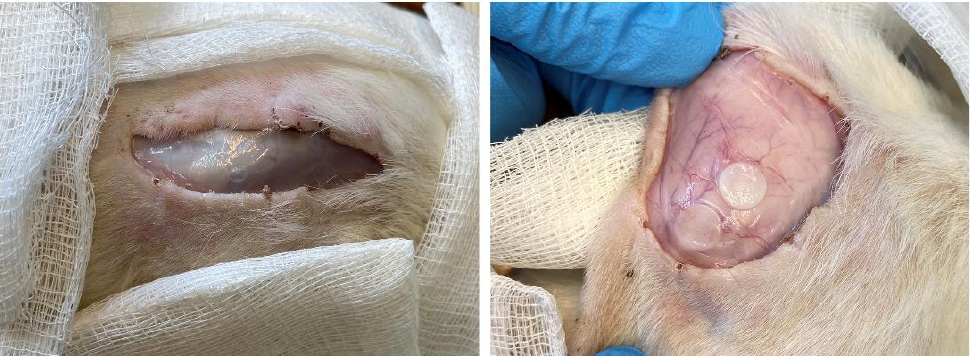
Figure 1. Subcutaneous administration of the polymer films.